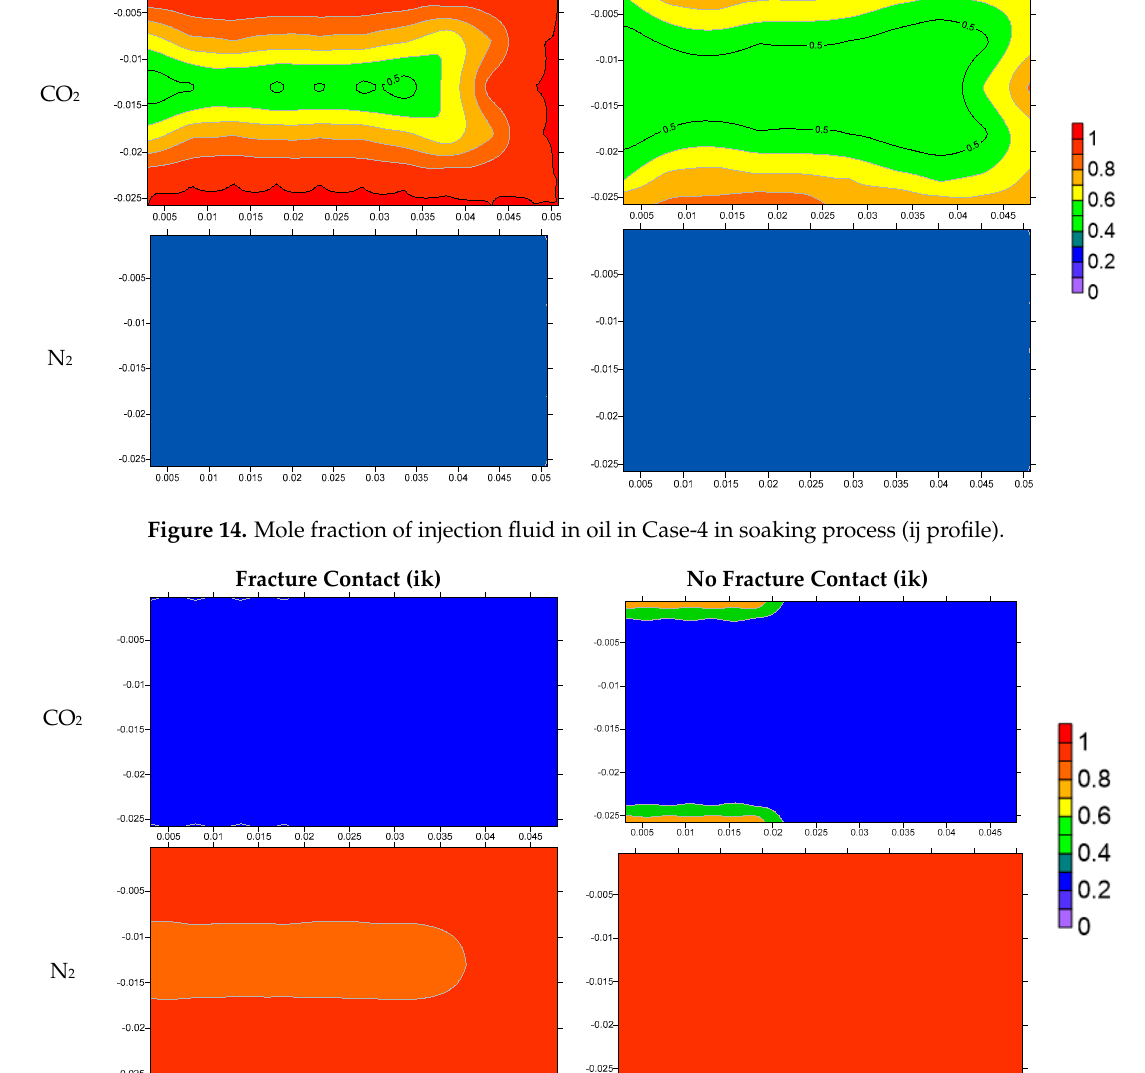
Figure 15. Mole fraction of injection fluid in gas in Case-4 in soaking process (ij profile).